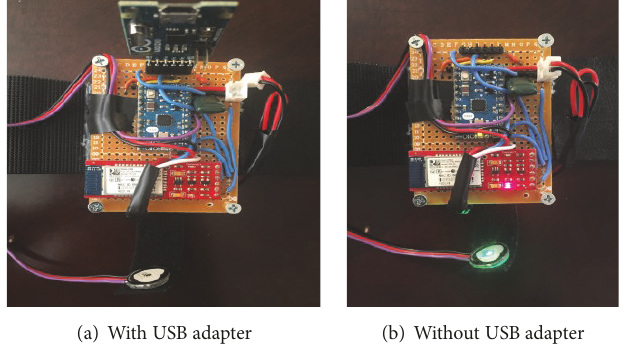
Figure 4: Wearable IoT